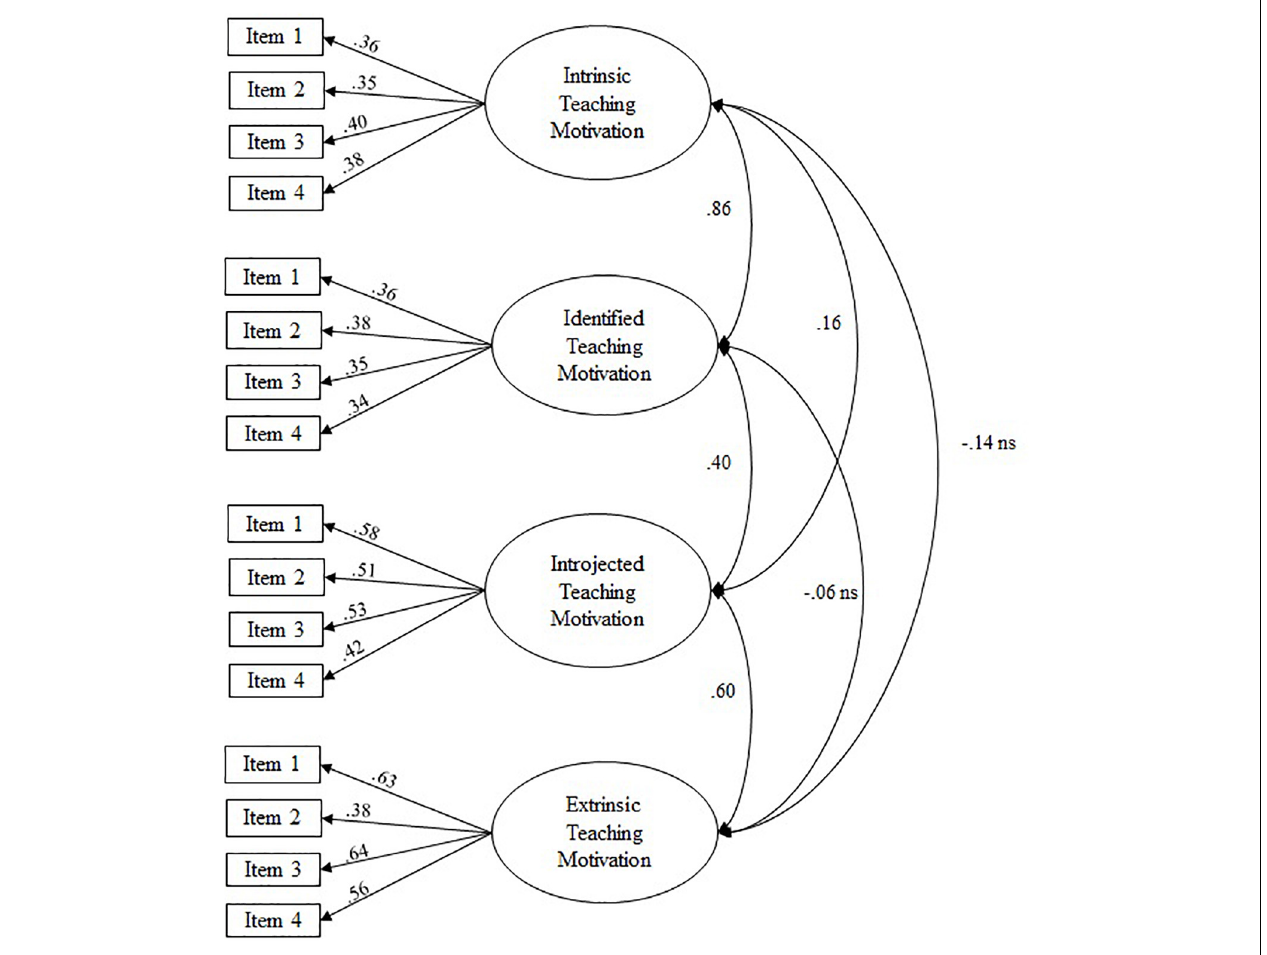
FIGURE 2 | Path coefficients from confirmatory factor analyses: four-factor model of teaching motivation. Figure depicts standardized loadings; all loadings and correlations are significant ( p < 0.05) if not otherwise stated; correlations between latent variables were specified as residual error